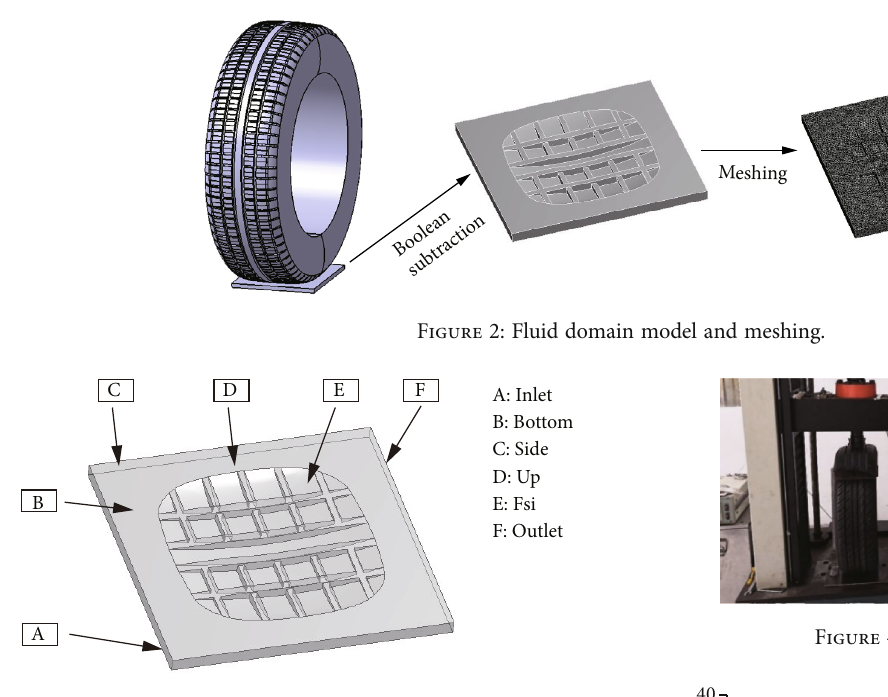
Figure 3: Boundary conditions of tire hydroplaning model.